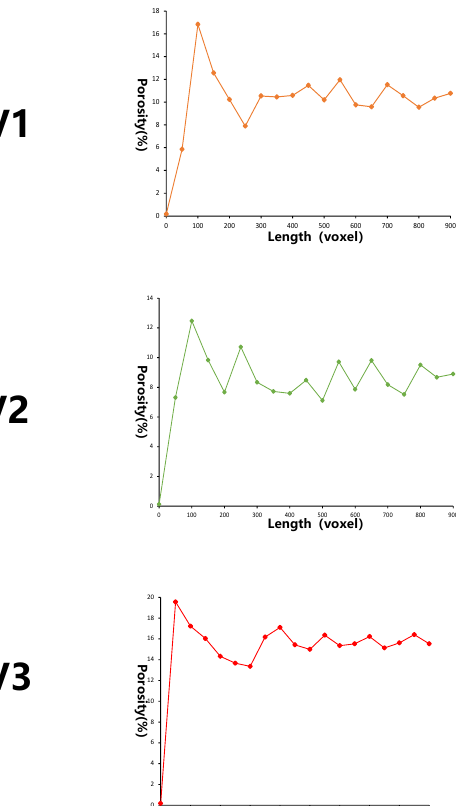
Figure 5. Schematic diagram of REVs oriented at three different subdomains (upper (orange), middle (gray) and bottom (green)) divided from a whole-core computational domain of CT-scanned rock sample.